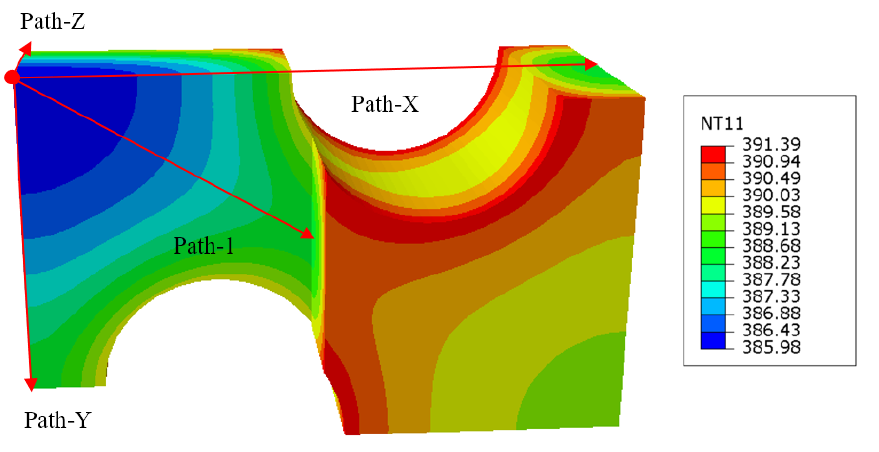
Figure 13. Heat transfer results and path specification of triaxial geogrid with a pre-punched diameter of 3.5